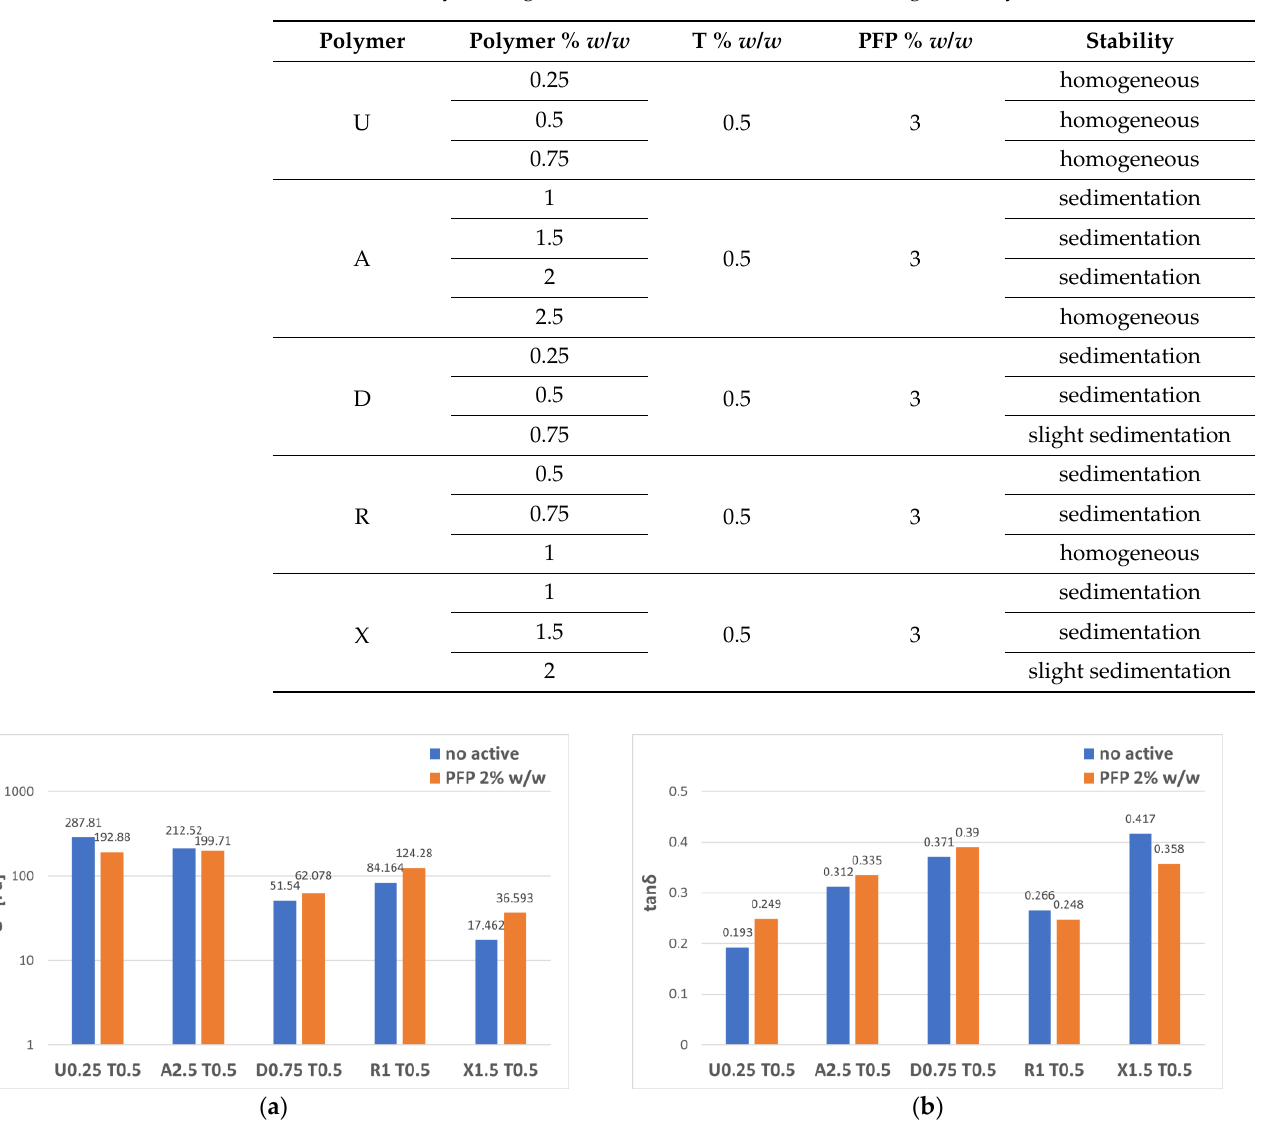
Figure 2. Comparison between the rheological parameters measured before and after adding 2%